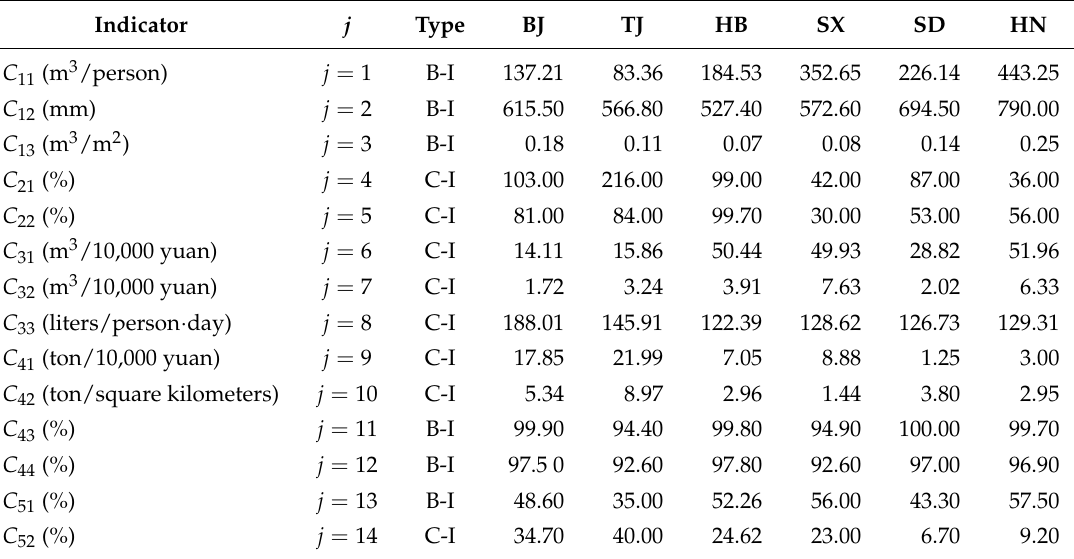
Table 2. Values of the indicators in 6 regions